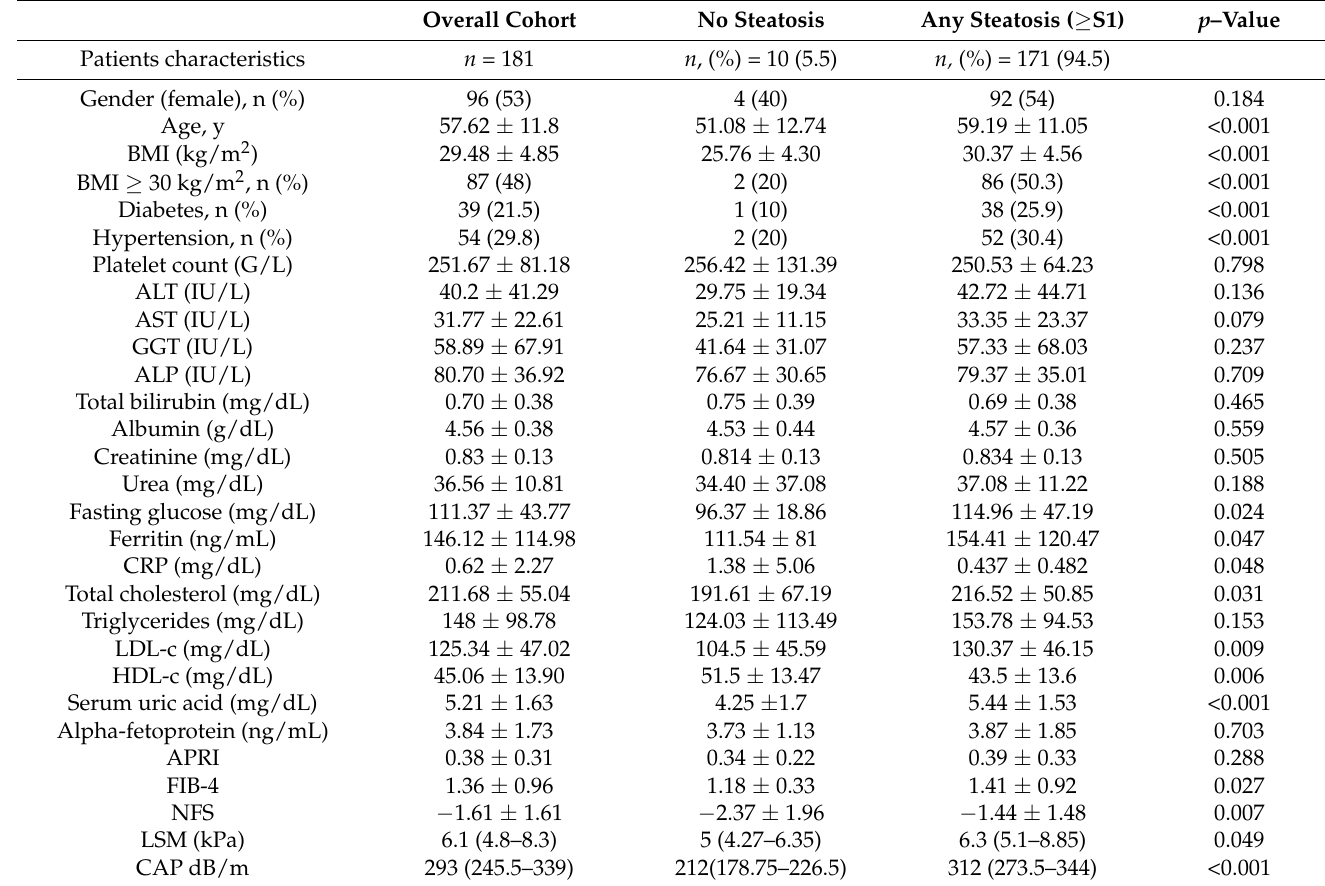
Table 1. Baseline characteristics of patients according to the presence of hepatic steatosis ( ≥ S1). Overall Cohort No Steatosis Any Steatosis ( ≥